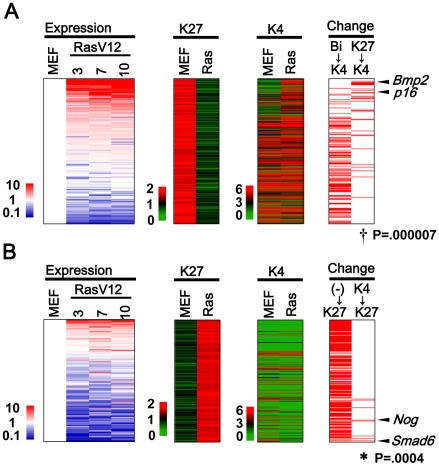
Genes with H3K27me3 alteration.(A) 284 Genes losing H3K27me3 mark, i.e. from >1.5 in MEFp2 to <1.0 in RasV12 cells (K27 column), were sorted by the fold expression change between MEFp2 and mean of RasV12 cells day3, 7, and 10 (Expression column). Upregulated genes were sorted upward (red). 30 genes losing H3K27me3 and gaining H3K4me3 simultaneously showed significant enrichment upward (Change K27→K4 column, †P = 0.000007, Kolmogorov-Smirnov test), e.g. p16. Bmp2 was found to be the most activated secreted factor among the 30 genes, and activated more than p16. Genes are listed in Table S3. 110 genes with bivalent modification in MEFp2 lost H3K27me3 and sustained H3K4me3 mark in RasV12 cells (Bi→K4), but did not show significant enrichment upward (P = 0.9). (B) 239 genes gaining H3K27me3 mark, i.e. from <1.0 in MEFp2 to <1.5 in RasV12 cells (K27 column). 189 genes had neither modification in MEFp2 (K27 column and K4 column), generally showed very low expression, and did not show significant enrichment downward (P = 1, (-)→K27). However, 9 genes gained H3K27me3 and lost H3K4me3 simultaneously, showed significant enrichment downward (K4→K27, *P = 0.0004), and included Smad6 and Nog. Genes were listed in Table S4.